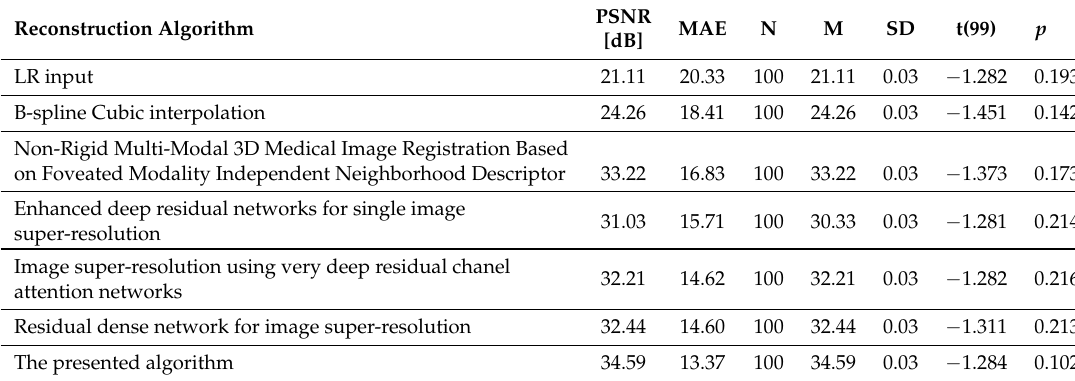
Table 9. Statistical parameters of the model performance metrics for Figure 9.